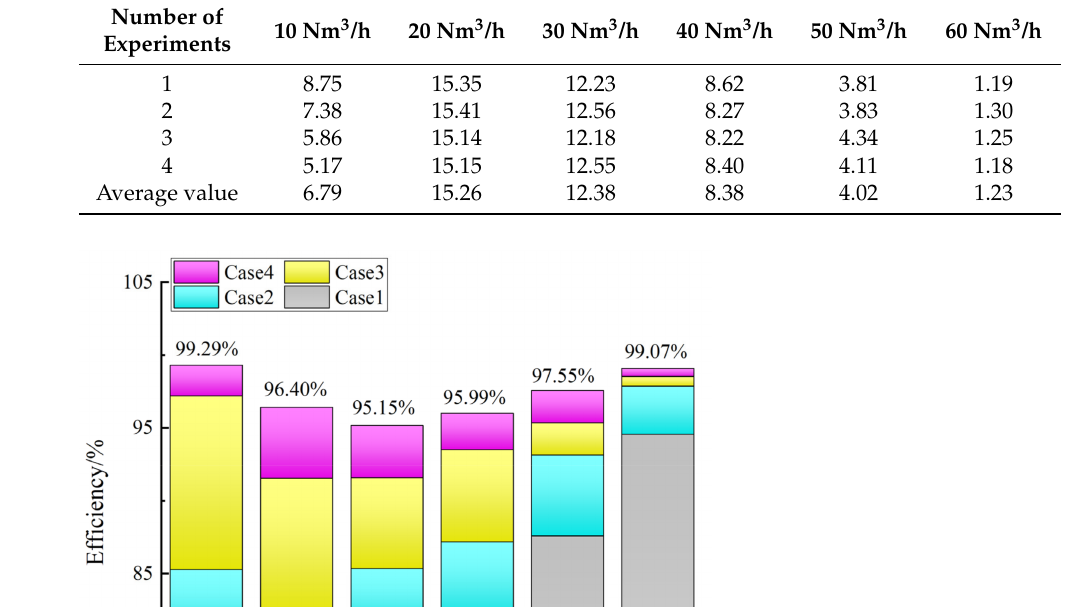
Table 18. Liquid content in Case 4 at M 2 (g/m 3 ).